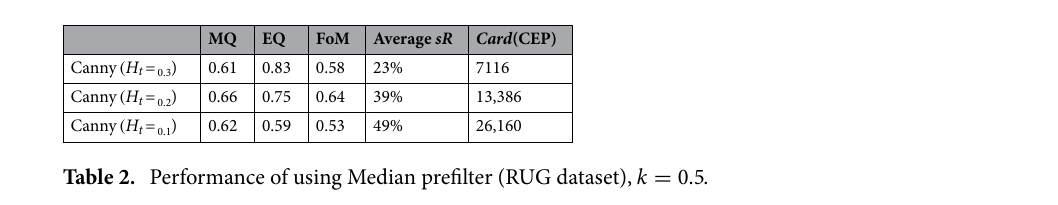
Table 2. Performance of using Median prefilter (RUG dataset), k = 0.5 .